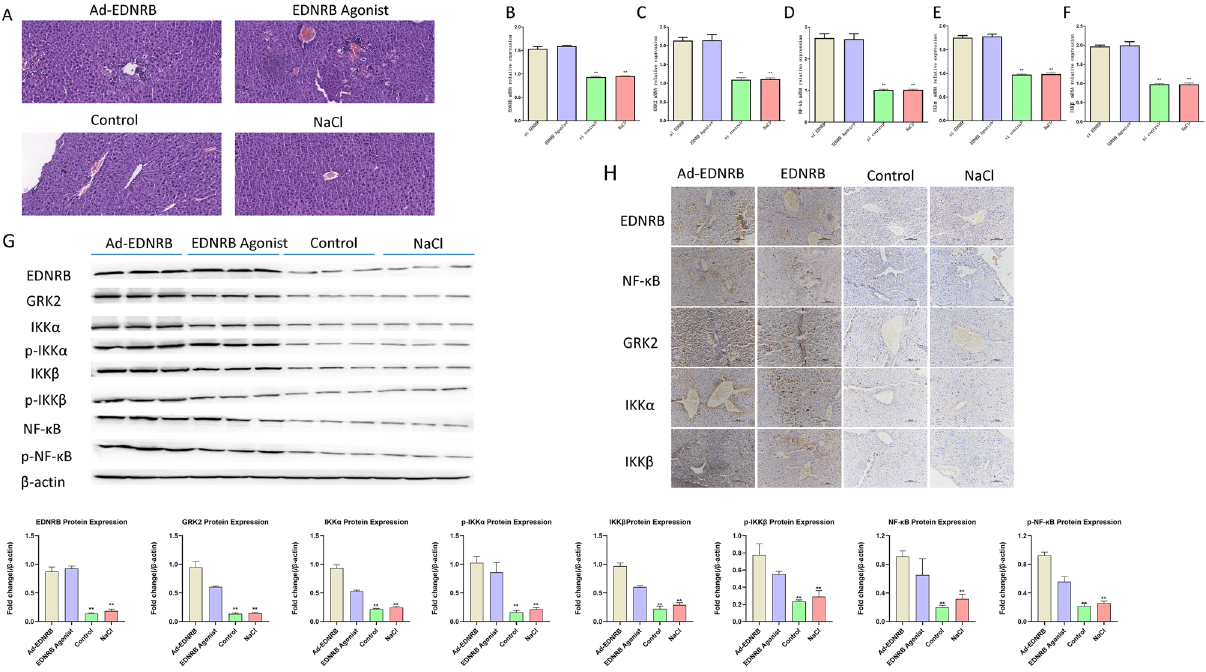
Figure 6. EDNRB overexpression or activation induced liver damage by increasing GRK2 expression and activating NF-κB pathway in wild type mice. ( A ) HE staining of liver tissues of mice injected with normal saline (NaCl), control adenoviruses (Control), Ad-EDNRB adenoviruses (Ad-EDNRB), or IRL-1620 TFA (EDNRB agonist) Each group contained 10 mice.. ( B – F ) The mRNA levels of EDNRB, GRK2, NF-κB, IKKα and IKKβ were measured with RT-qPCR assay in liver samples of mice injected with normal saline, control adenoviruses, Ad-EDNRB adenoviruses, or IRL-1620 TFA. ( G ) Western blotting technique was used to detect protein levels of EDNRB, GRK2, NF-κB, IKKα, IKKβ, p-NF-κB, p-IKKα, and p-IKKβ in liver tissues of mice injected with normal saline, control adenoviruses, Ad-EDNRB adenoviruses, or IRL-1620 TFA. ( H ) Levels of EDNRB, GRK2, NF-κB, IKKα, and IKKβ proteins were measured with IHC assay in liver tissues of mice injected with normal saline, control adenoviruses, Ad-EDNRB adenoviruses, or IRL-1620